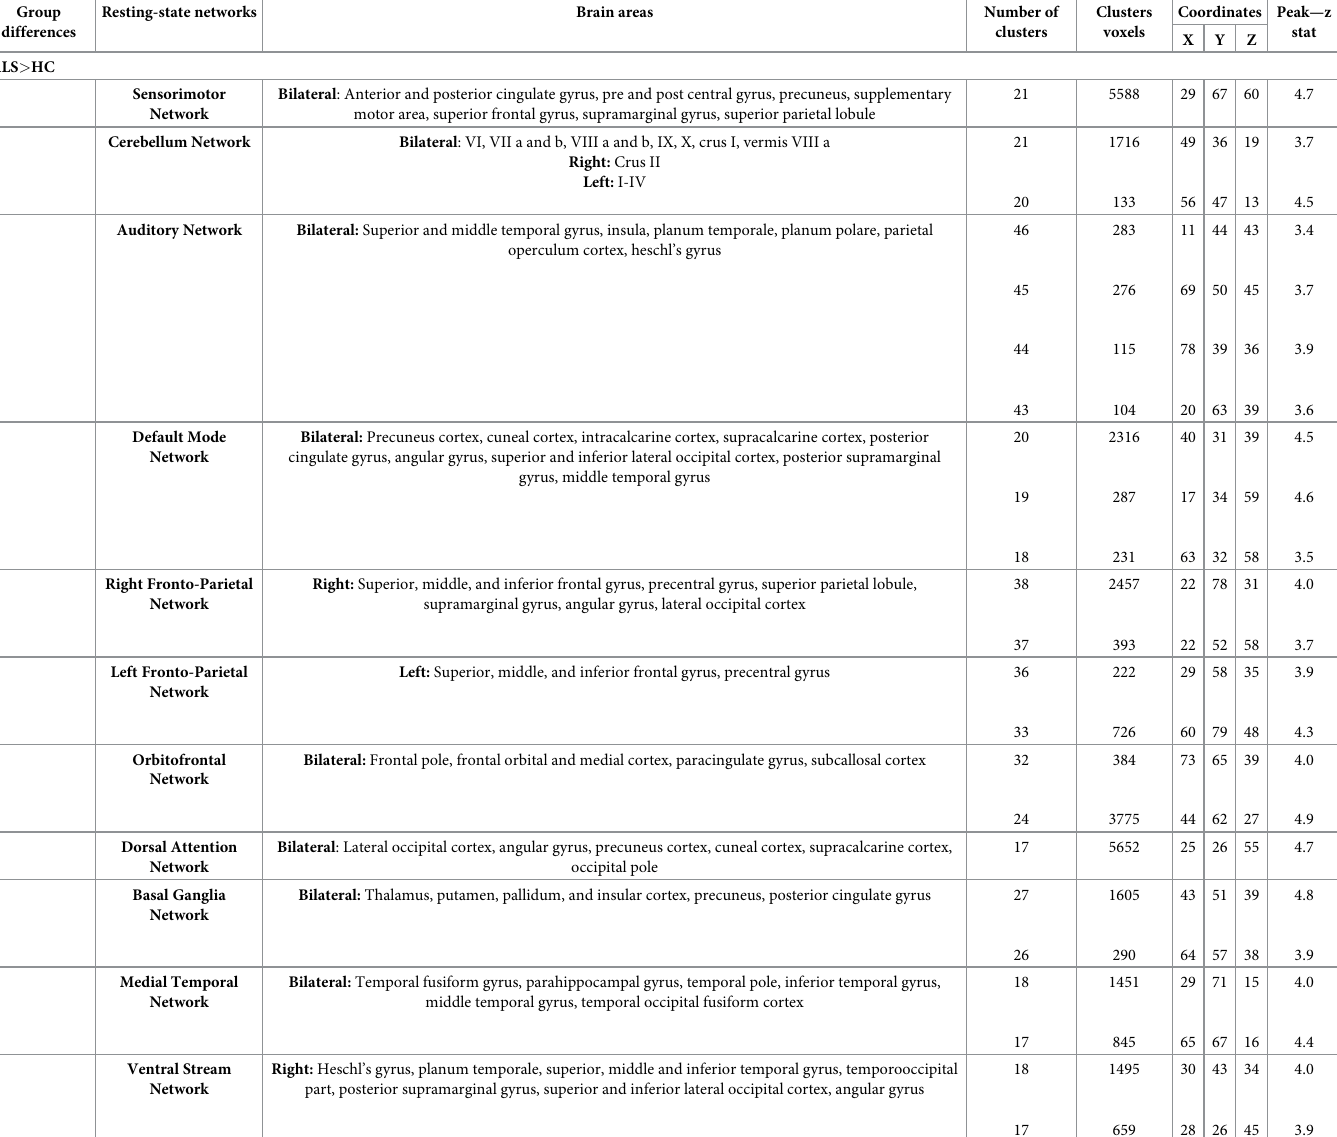
Table 3. Brain areas exhibiting higher intra-network resting-state functional connectivity (Rs-FC) in resting-state networks (RSNs). Group